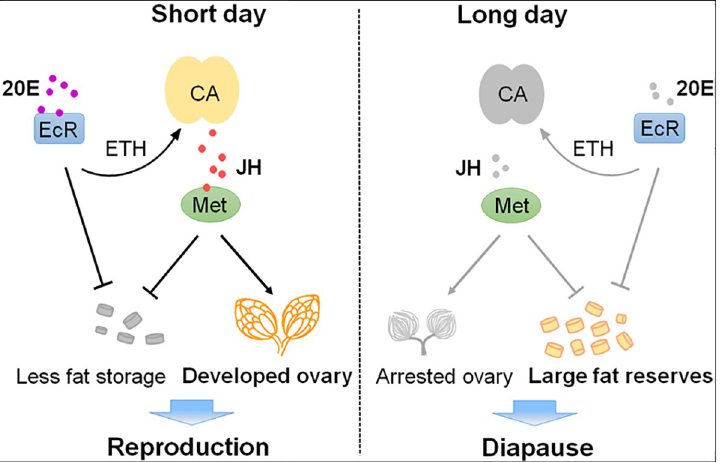
Fig 8. Model for 20E signaling in photoperiodic reproduction and diapause of C . bowringi females. 20E signaling under the short-day (SD; 12 h light, 12 h dark) condition, results in ovarian development via ETH-JH signaling. 20E- regulated JH signaling also inhibits lipid storage to block diapause preparation. Under the long-day (LD; 16 h light, 8 h dark) condition, 20E and ETH signaling is shut down and JH biosynthesis is inactivated, resulting in accumulation of lipid stores. In addition, 20E could suppress lipid accumulation and might be independent of JH signaling. Arrows represent promotion and T-bars represent inhibition. Gray and black represent the OFF and ON activity states of the genes or physiological processes,